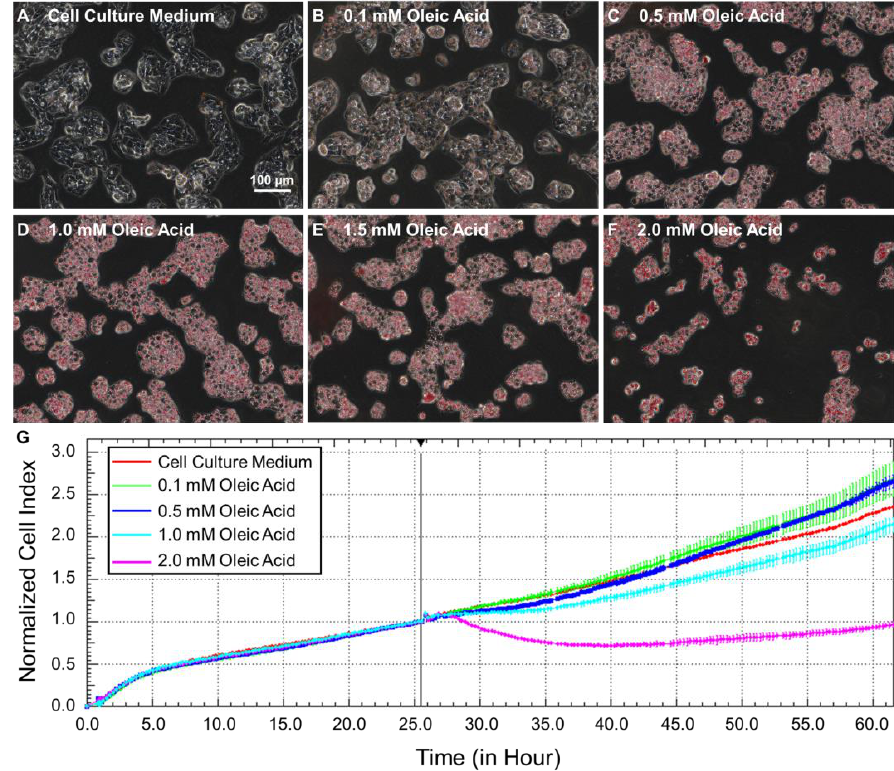
Figure 2. Steatotic hepatocyte modeling. ( A – F ) Micrograph of HepG2 cells with oil red O staining after 24 h treatments with OA of various concentrations. ( G ) Real-time growth status of HepG2 cells, as reflected by normalized cell index, in response to OA exposures.